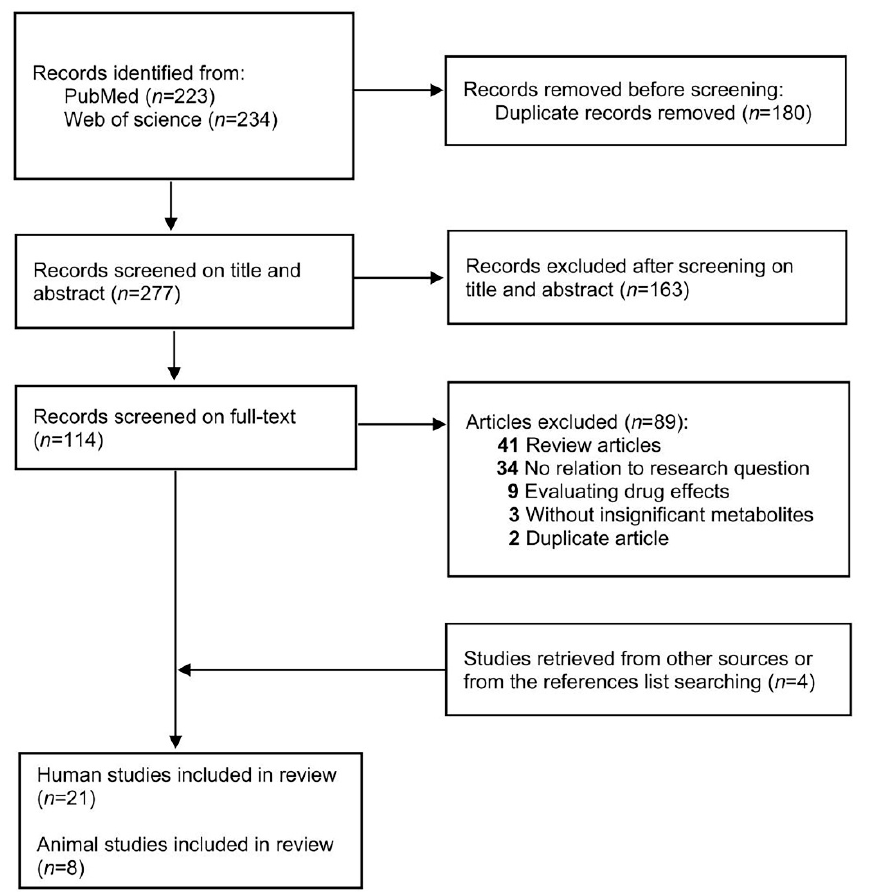
Figure 1. PRISMA flowchart of study selection.